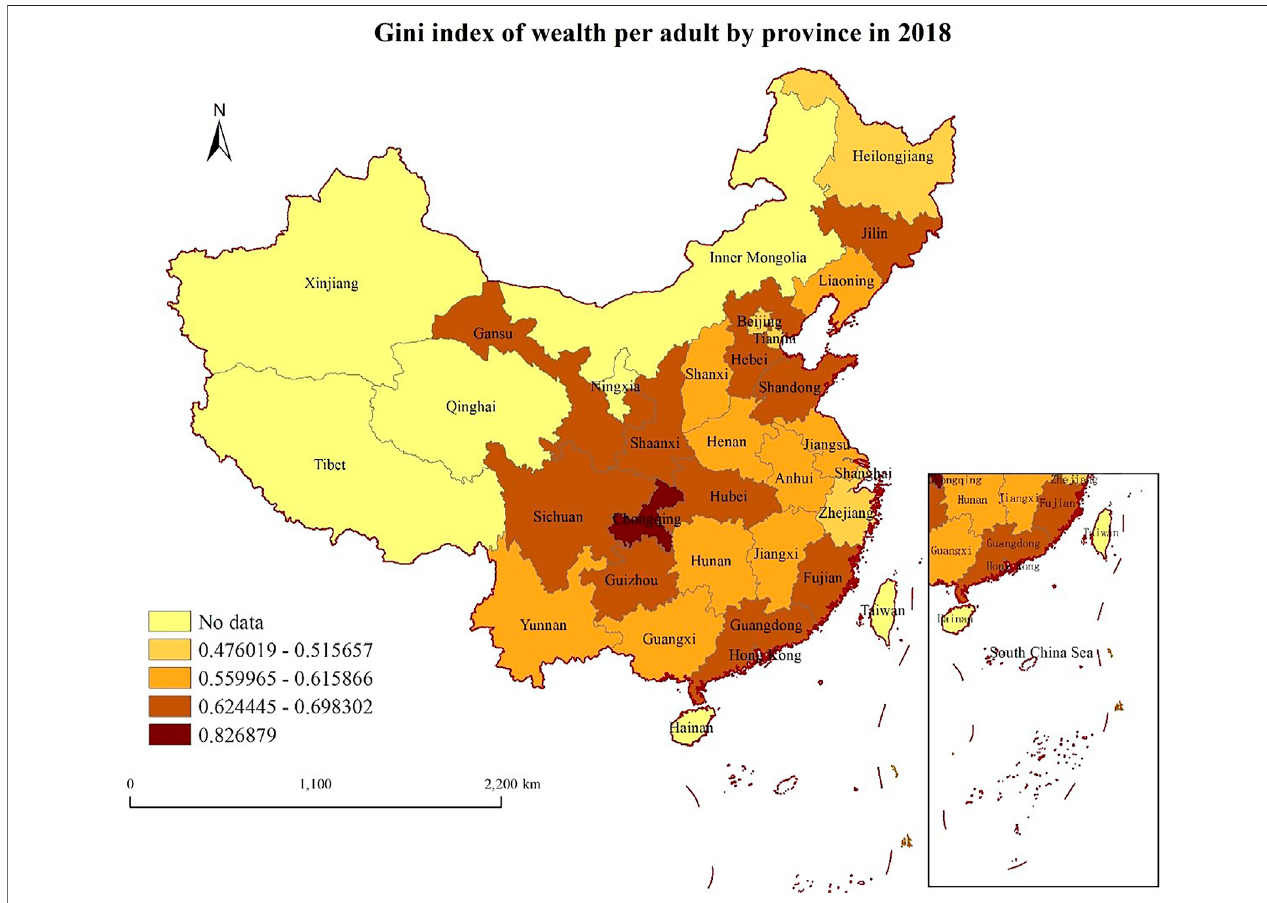
FIGURE 2 | Gini coef fi cient of wealth per adult by province in 2018.